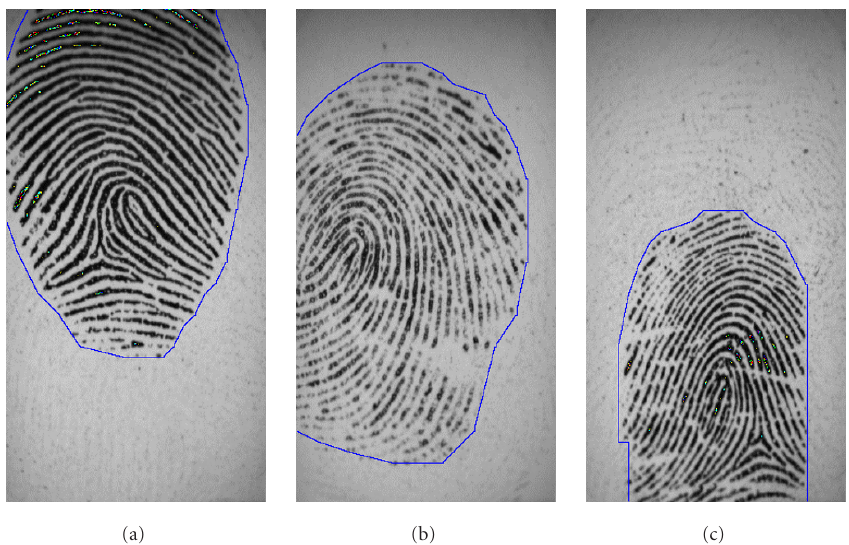
Figure 26: Segmentation results of three fingerprints from FVC2002 DB2: (a) is from the training data, (b) and (c) are from the test data.